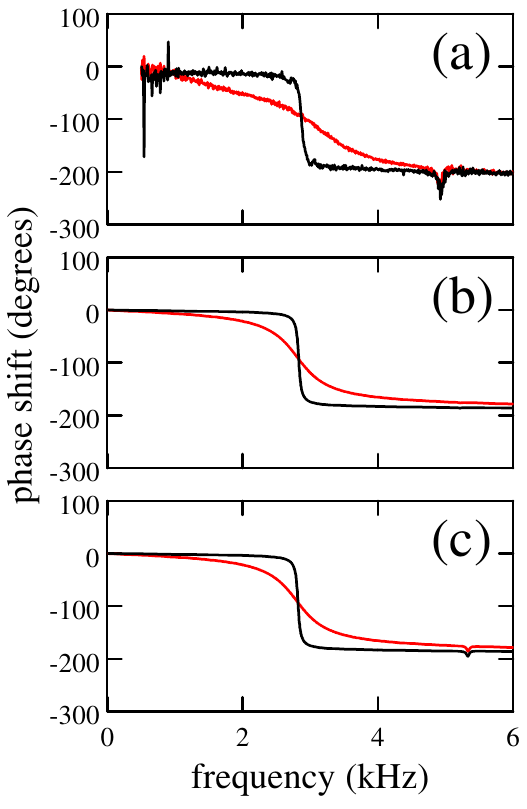
FIG. 2. (Color) Operation with passive harmonic-cavity voltage equaling 22% of that required for optimal bunch lengthening. Black curves: phase feedback off. Red curves: phase feedback on. (a) Experimental measurement of the transfer function phase shift. (b) Phase shift calculated with the beam energy spread equaling its natural value. (c) Phase shift calculated with the beam energy spread equaling 3 times its natural value.